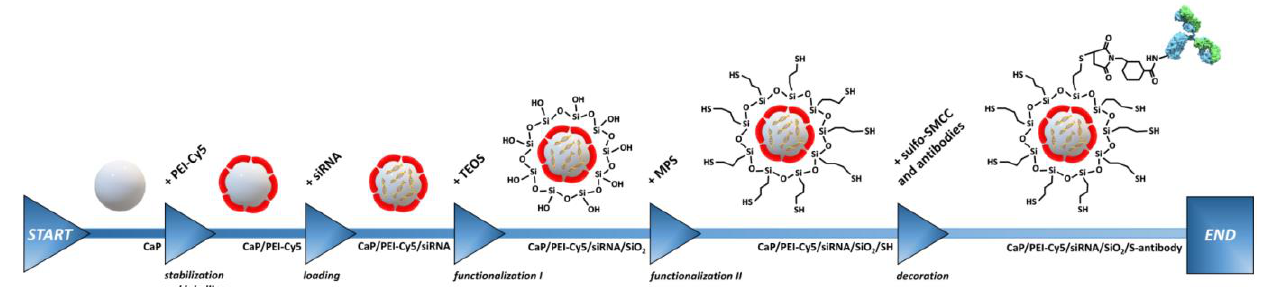
Figure 1. Schematic representation of the synthesis of fluorescent ligand-decorated and siRNA-loaded calcium phosphate nanoparticles (CaP/PEI-Cy5/siRNA/SiO 2 /S-peptide/antibody) for in vitro cell targeting and gene silencing of p65 NF- κ B in murine cells. CaP—calcium phosphate, Cy5—cyanine 5, MPS—(3-mercaptopropyl)trimethoxysilane, PEI—polyethyleneimine, siRNA—small interfering RNA, sulfo-SMCC—sulfo-N-succinimidyl 4-(maleimidomethyl) cyclohexane-1-carboxylate sodium salt, TEOS — tetraethoxysilane. The image of the antibody was adapted 176 from static.turbosquid.com.